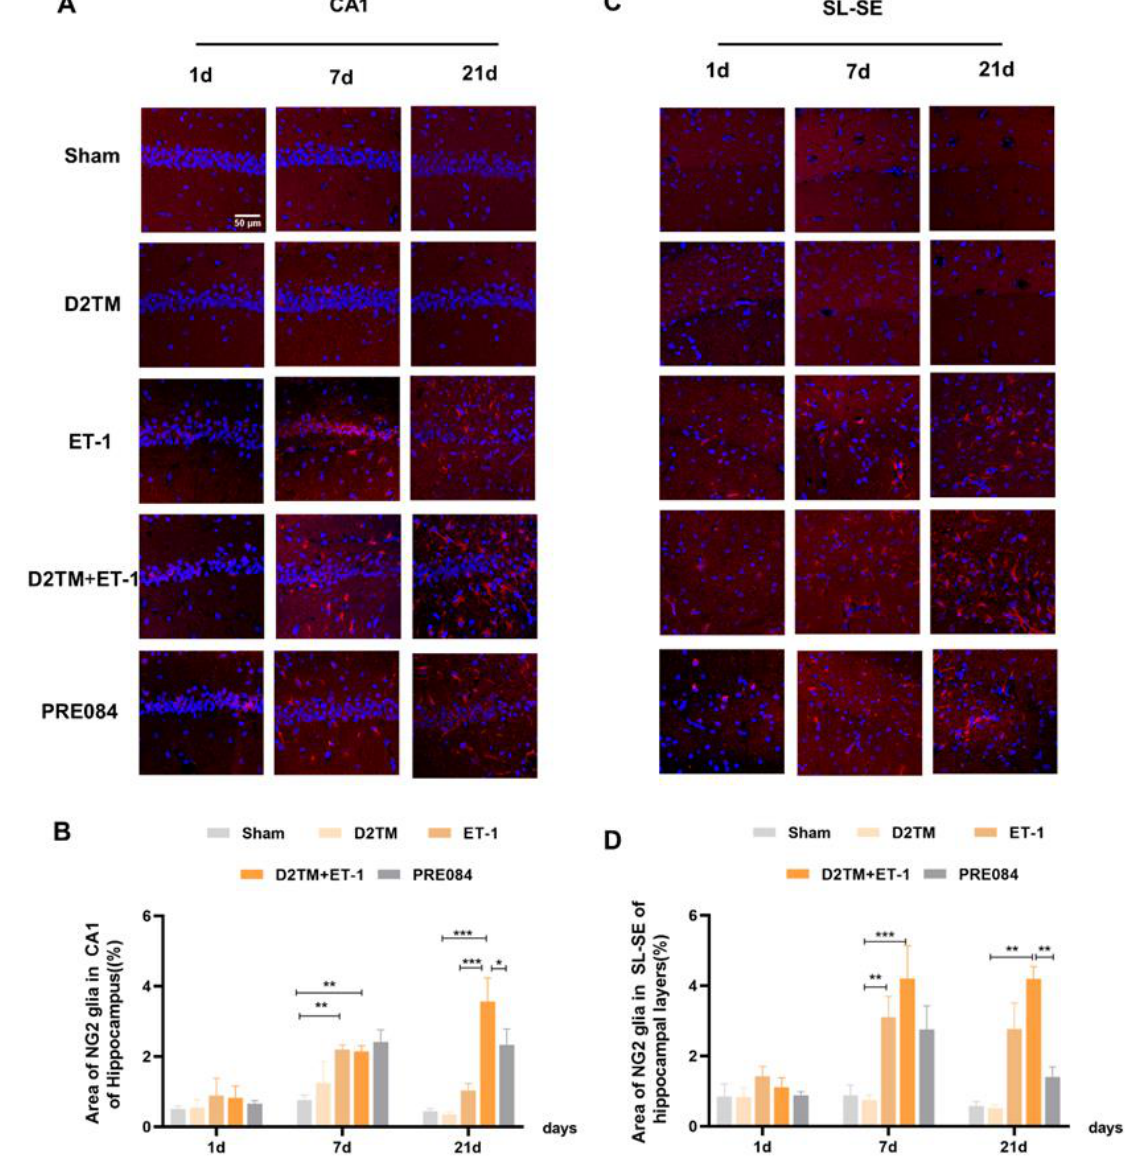
Figure 8. PRE084 regulated OPC proliferation in mice with diabetes and stroke. ( A , C ) NG2 immunostaining (red) with DAPI (blue) was performed to detect oligodendrocyte progenitor cells in the CA1 and the SL–SE hippocampal layers at 1, 7, and 21 d after ET-1 injection. ( B , D ) Quantification of the area of the NG2-immunostained cells in the CA1 and SL–SE of the hippocampus. Data are expressed as mean ± SEM; n = 4–5/group. Scale bars = 25 µ m. * p < 0.05, ** p < 0.01, *** p < 0.001.